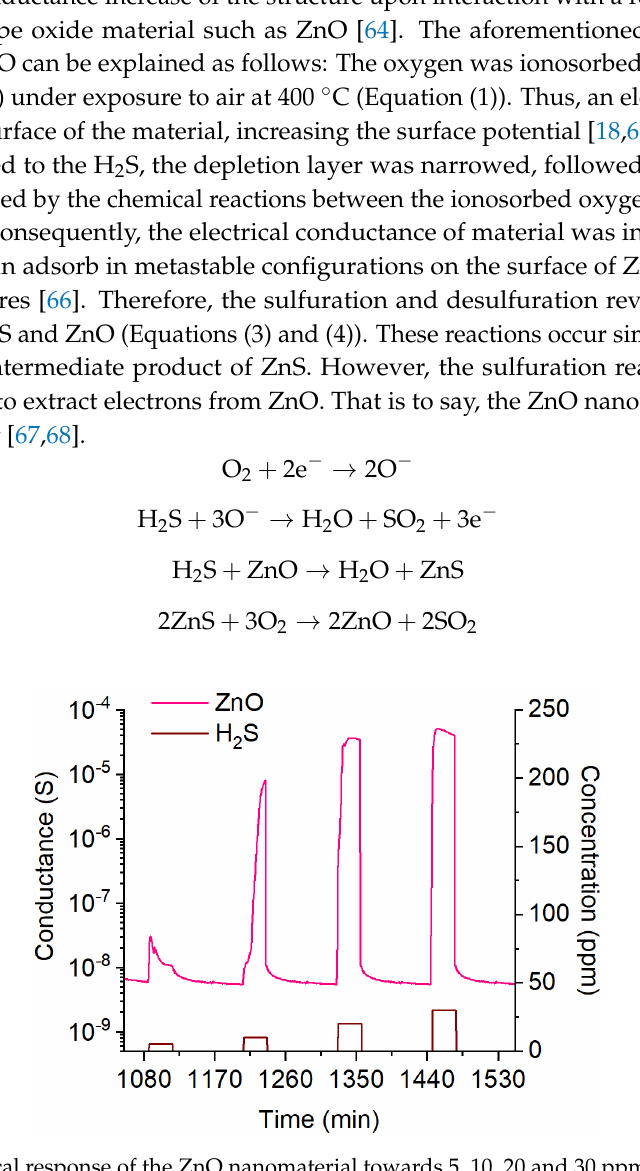
Figure 3. Dynamical response of the ZnO nanomaterial towards 5, 10, 20 and 30 ppm of H 2 S at 400 °C.